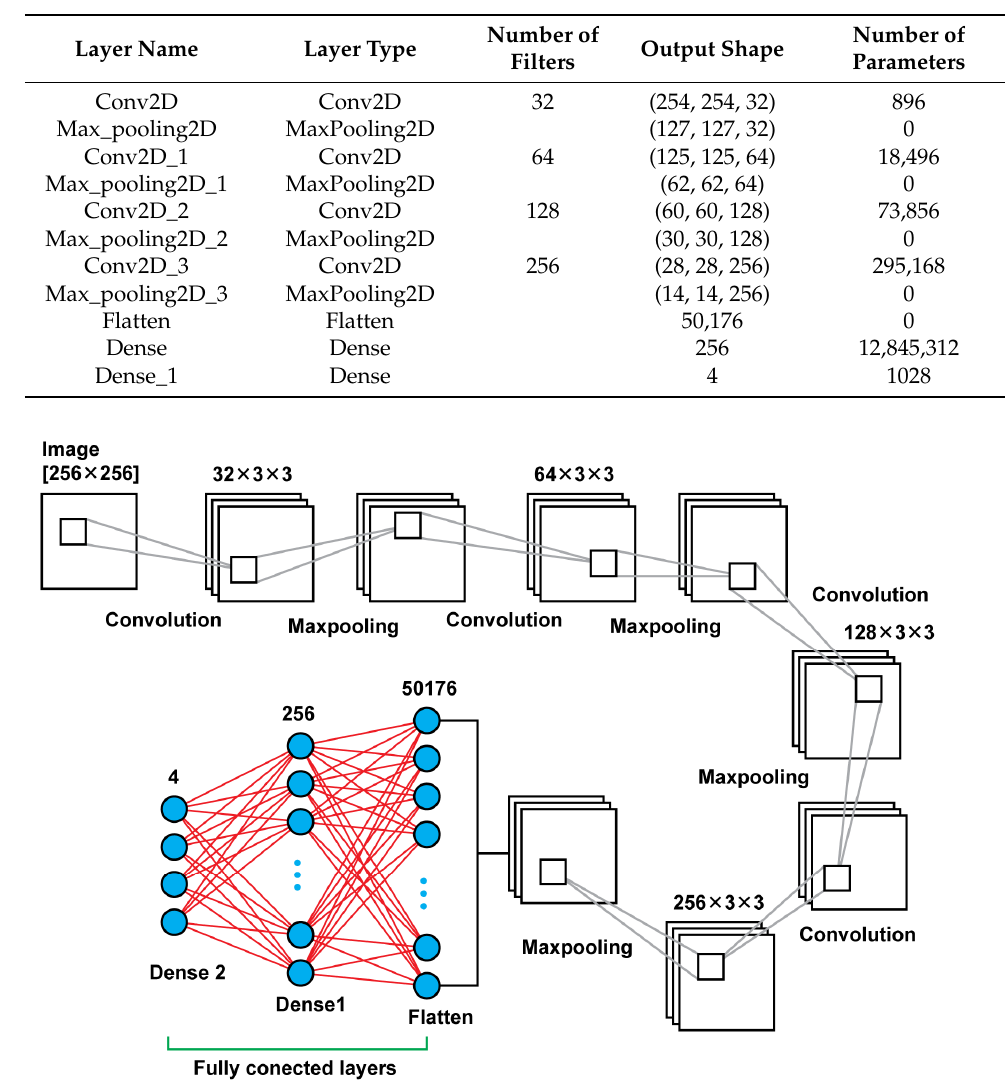
Table 2. Model 2 summary.